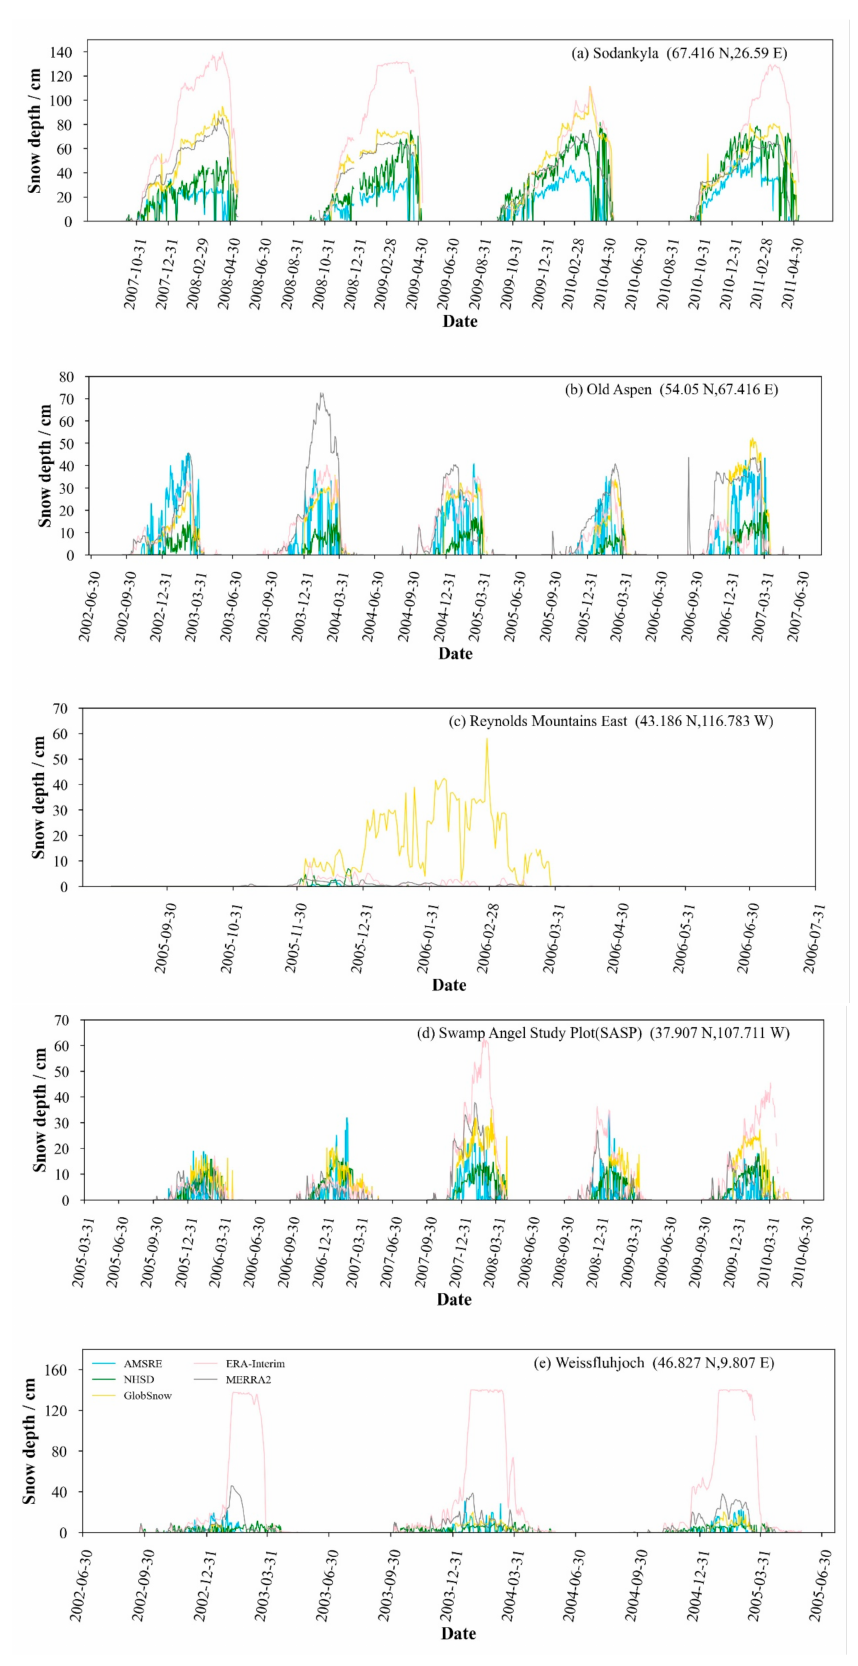
Figure A1. Original gridded snow depth datasets of five independent snow observation